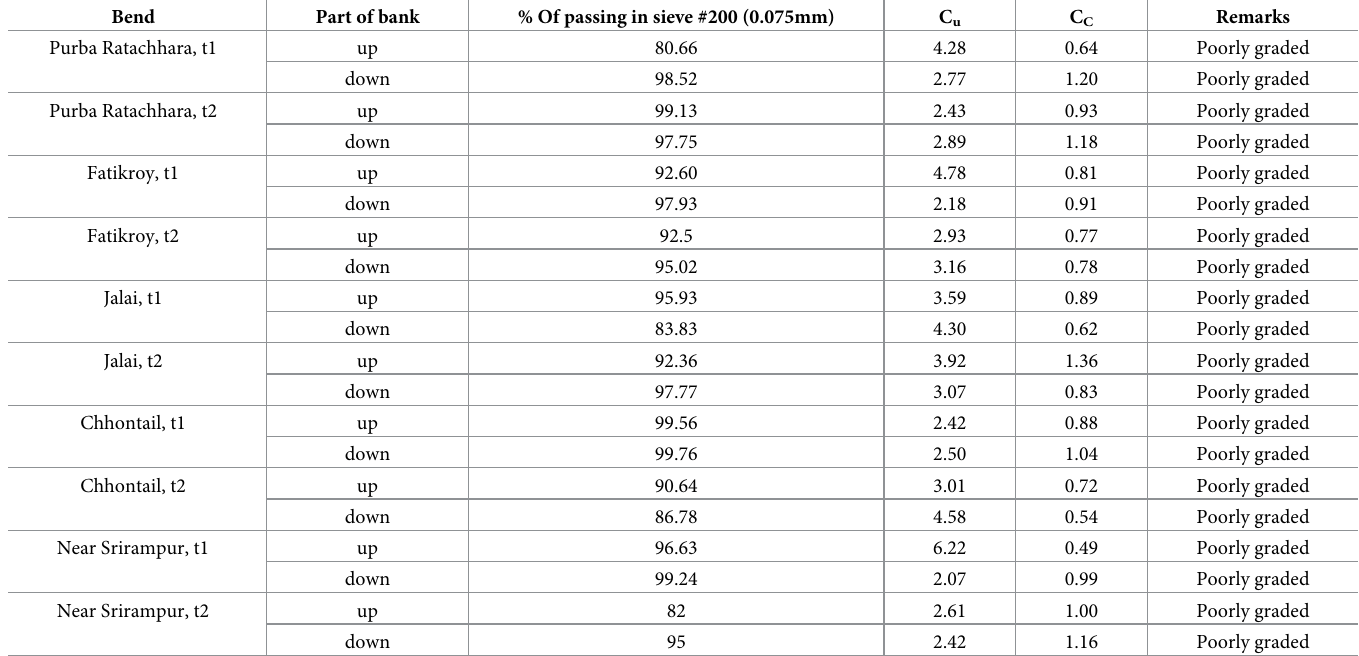
Table 9. Grain size analysis of the collected soil samples of the Manu Riverbank.